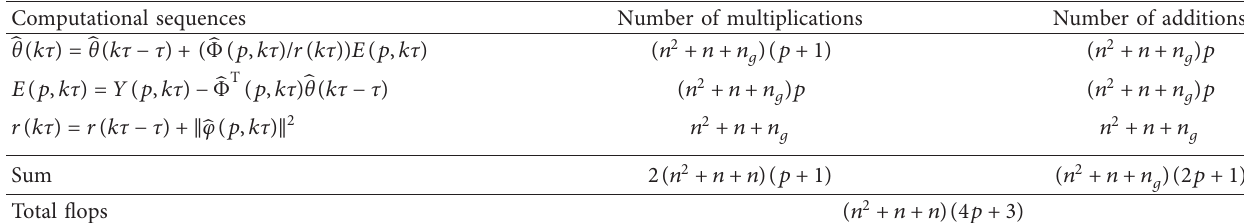
Table 1: The computational burden of the MISG algorithm.